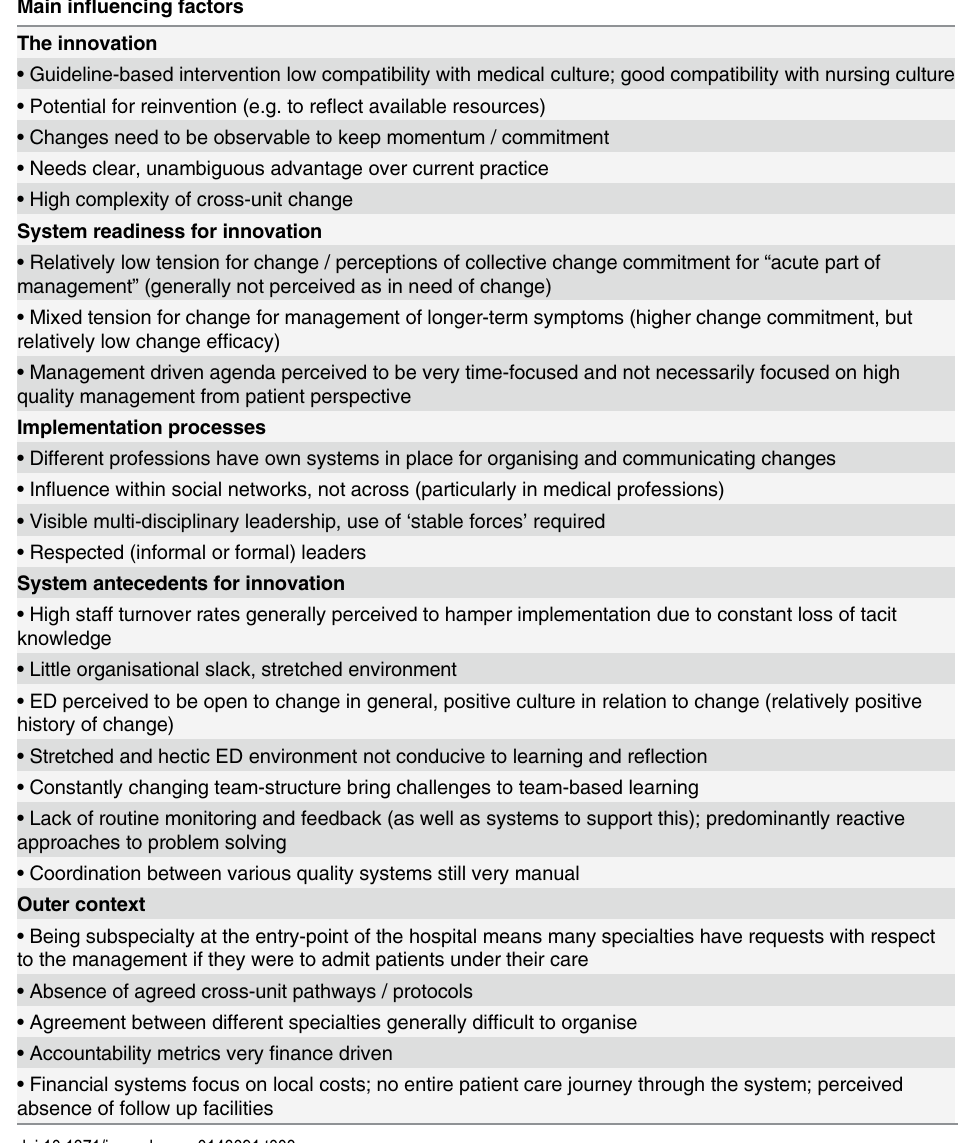
Table 3. Summary of main